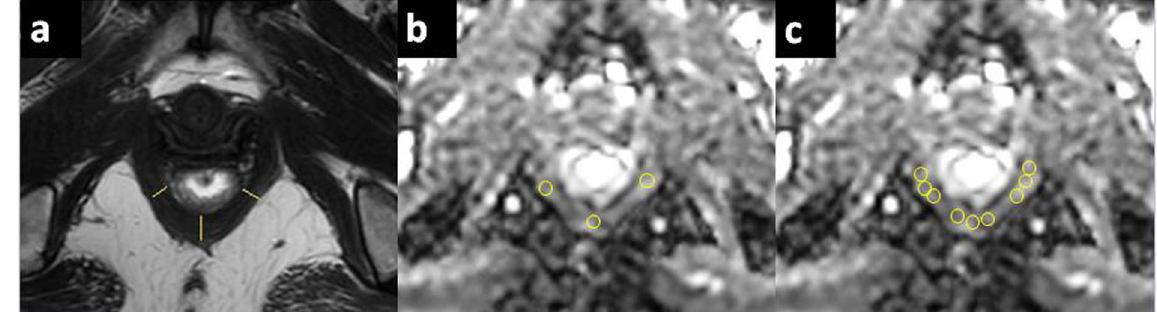
Figure 2. Measurement of puborectalis thickness and ADC. ( a ) Measurement of puborectal thickness where the puborectalis is at its widest (adjacent to the rectal wall at the point where the fibres attach to the pubis; the yellow lines indicate where the puborectal thickness measurements were obtained, right in the middle and at a third of the total length of each branch. ( b ) ROIs were placed at the slice where the puborectalis was widest. An ROI was first placed at the point of the thickest slice of the middle zone (M zone). Then, ROIs were placed at a third of the total length of the left and right branches, close to the M zone. ( c ) Another method for placing ROIs to increase the numbers of voxel is to add two ROIs on both sides of original ROI and average the values of the three ROI to get the final